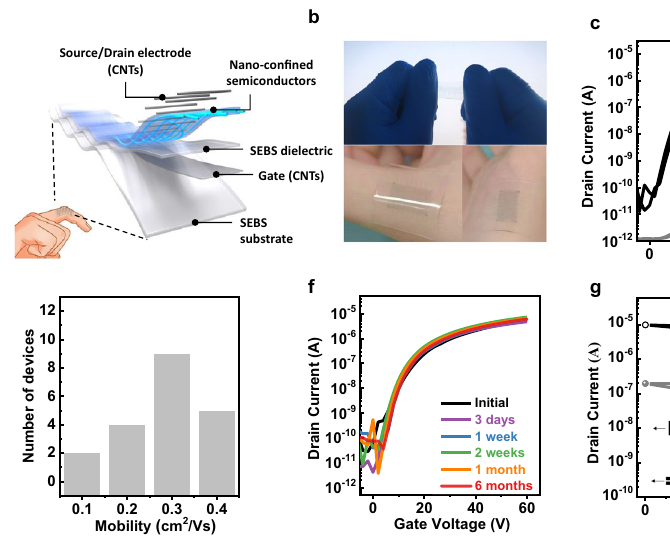
Fig. 2 | Intrinsically stretchable transistors fabricated using the OCSC n-type hybrid polymer semiconductor fi lms. a Device structure of the STOFETs with channel length/width of 200 µ m/4mm and dielectric thickness of about 2000nm. b Images showing the skin-like characteristics of the stretchable transistor. c A typical transfer curve ( V DS =60V, with V DS representing drain voltage) from the STOFET device fabricated using the OCSC n-type hybrid polymer semiconductor fi lms in its initial condition. d A typical output characteristic obtained from the OCSC n-type hybrid polymer semiconductor fi lms. e Distribution of the carrier mobility from 20 devices in a fully stretchable transistor array. f The real ‘ working